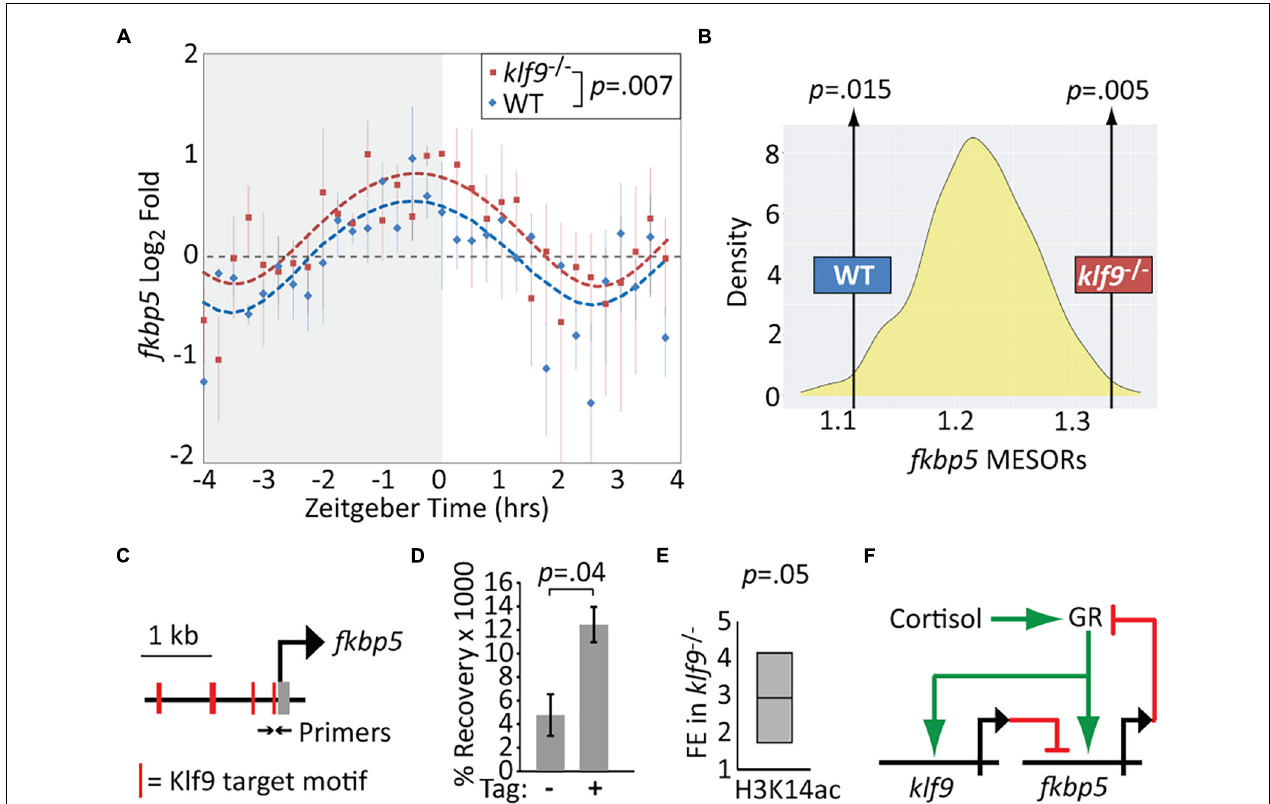
FIGURE 3 | Krüppel-like factor 9 (Klf9) regulates fkbp5 . (A) Sinusoid modeling of fkbp5 time-course data obtained by quantitative reverse transcription and polymerase chain reaction (qRT-PCR) of RNA extracted from wildtype (WT) and klf9 − / − larvae. Each data point represents the average of three biological replicates of pooled larvae. P -value calculated by paired t -test (data paired at each timepoint). Error bars represent standard error of the mean. Model fits tested by ANOVA ( P < 0.0001, see Supplementary Figure 4 ). (B) Distribution of Midline Estimated Statistics Of Rhythmicity (MESORs) of datasets generated by random sampling as described in Figure 2 and Methods. MESORs of measured WT and klf9 − / − data sit at either extreme. (C) Schematic of putative Klf9 target motifs in the fkbp5 promoter region. Black arrows indicate sites of primers used in panels (D,E) . (D) Recovery of fkbp5 promoter DNA from WT (-) and Klf9-AM tagged (+) larvae